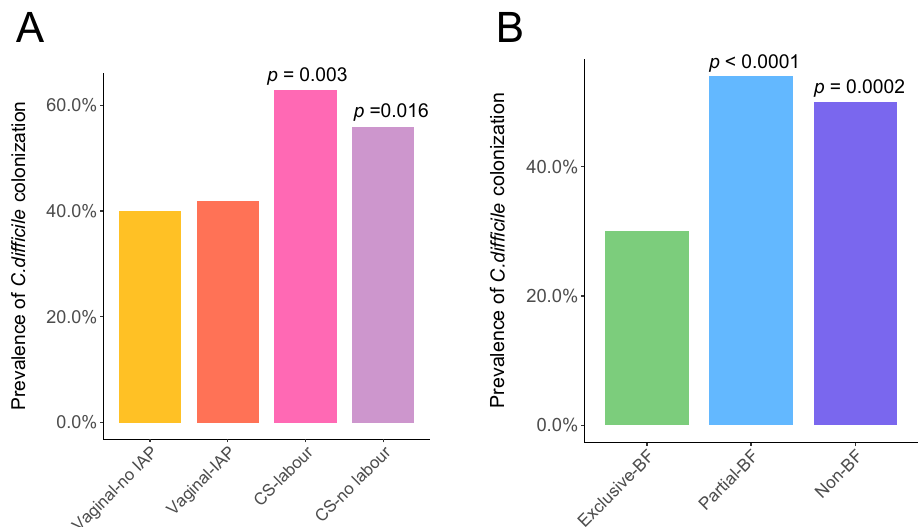
Figure 3. Prevalence of C. difficile colonization according to birth events ( A ) and breastfeeding exclusivity ( B ) at 3 months of age. Fisher’s exact tests with vaginal-no IAP or exclusive-BF as the reference